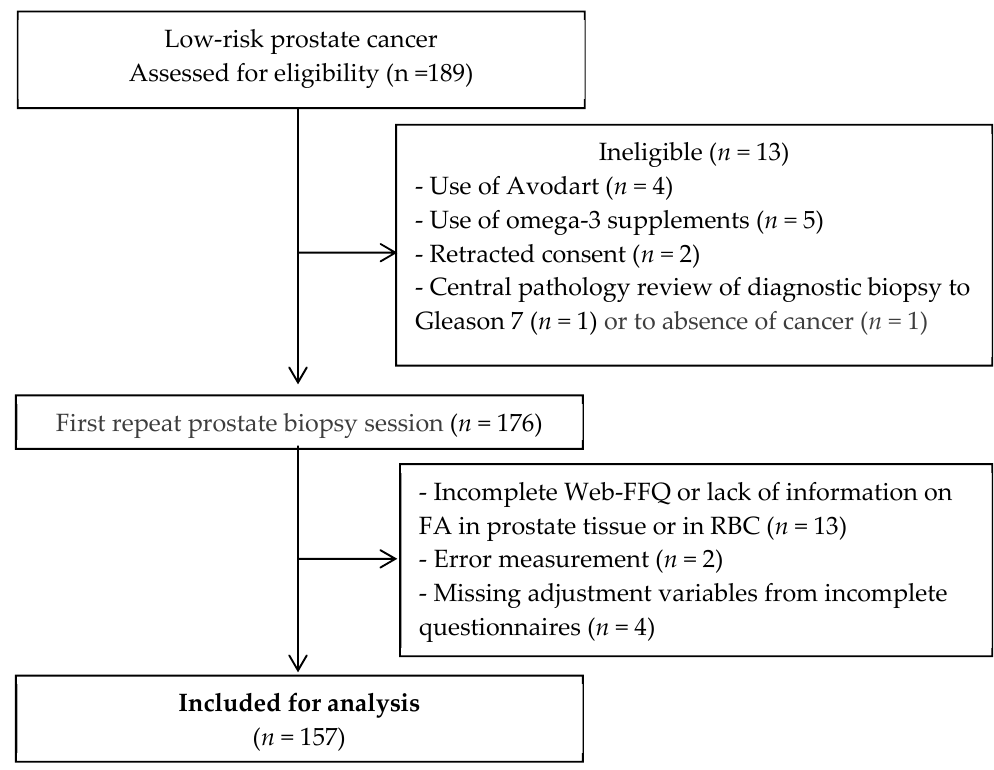
Figure 1. Flow chart of selection for study subjects. 189 men diagnosed with low-grade prostate cancer (PCa) and electing an active surveillance program were recruited for this study. After several months, men underwent a new prostate biopsy session (first repeat, or confirmatory biopsy) to assess PCa grade. Note: Web-FFQ = validated Food Frequency Questionnaire online; FA = Fatty Acids; RBC = Red Blood Cells.